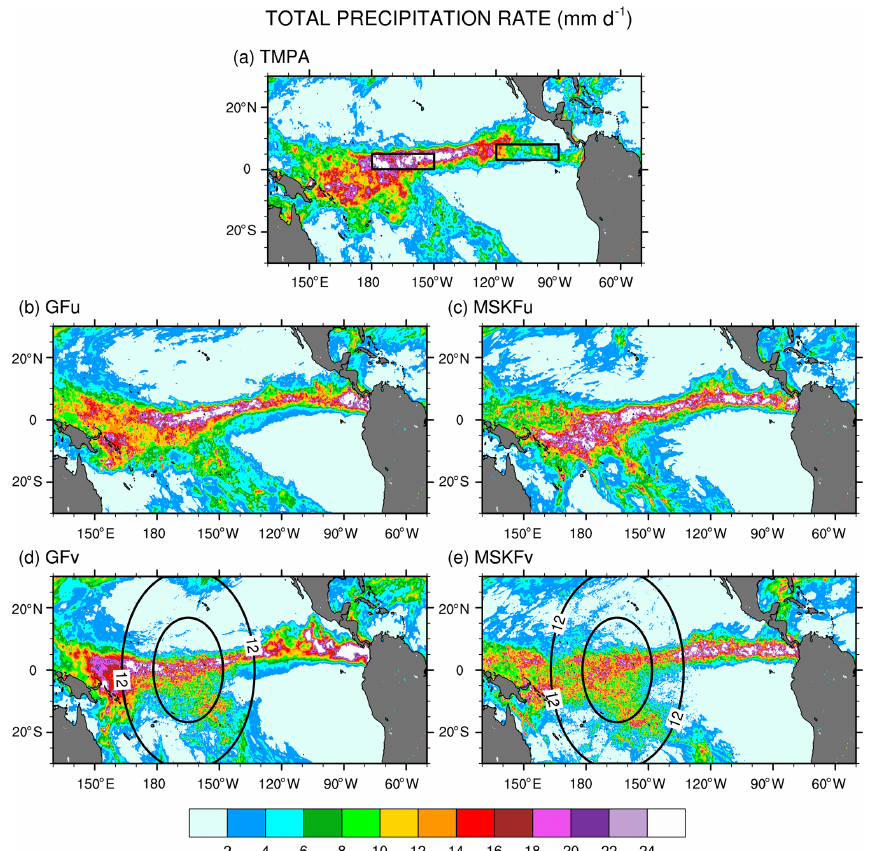
Figure 9. Monthly-mean total precipitation rate over the tropical Pacific Ocean from (a) TMPA data and simulated with (b, c) GFu and MSKFu and (d, e) GFv and MSKFv for December